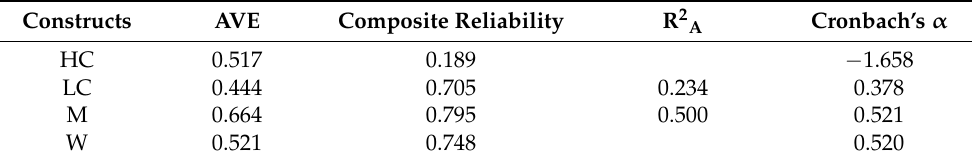
Table 3. Reliability measures.